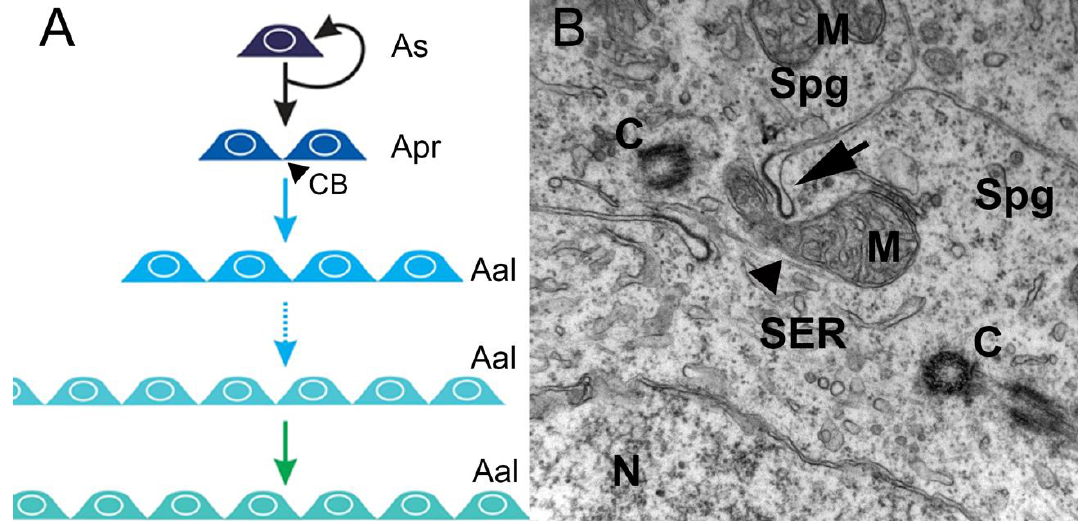
Figure 1. Mitotic/spermatogonial phase. ( A ) Mitosis produces spermatogonium clones. In rodents, type A single spermatogonia (As) harbor the spermatogonial stem cell population, which can either self-renew or generate two interconnected cells named type A-paired spermatogonia (Apr). The A-paired spermatogonia are interconnected by cytoplasmic bridge (CB) as a consequence of incomplete cytokinesis during cell division. Amplifying divisions beyond the A-paired also do not complete cytokinesis and continue to generate longer syncytial chains, termed A-aligned spermatogonia (Aal). ( B ). An electron micrograph showing a cytoplasmic bridge (arrow) connecting daughter cells resulting from spermatogonium division. The mitochondria (M), nucleus (N), smooth endoplasmic reticulum